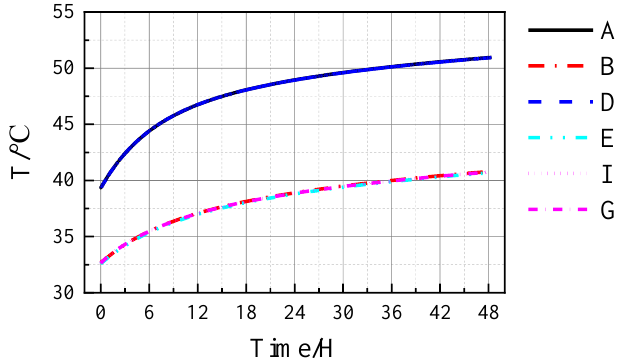
Figure 7. Transient temperature field inside the TPC.